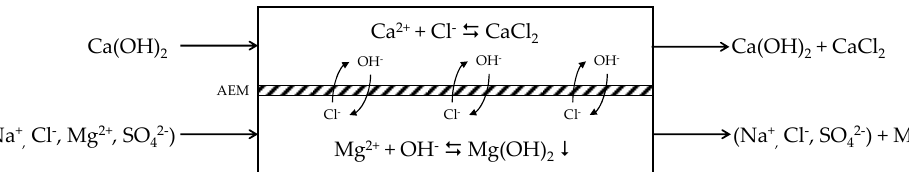
Figure 1. Process scheme of the ion exchange membrane crystallizer (CrIEM) technology for the precipitation of Mg(OH) 2 from Mg-rich brines.